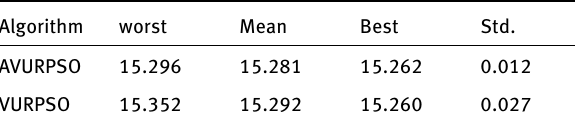
Table 2: A comparison between AVURPSO and VURPSO on statistical analysis of fitness function in Example 1.